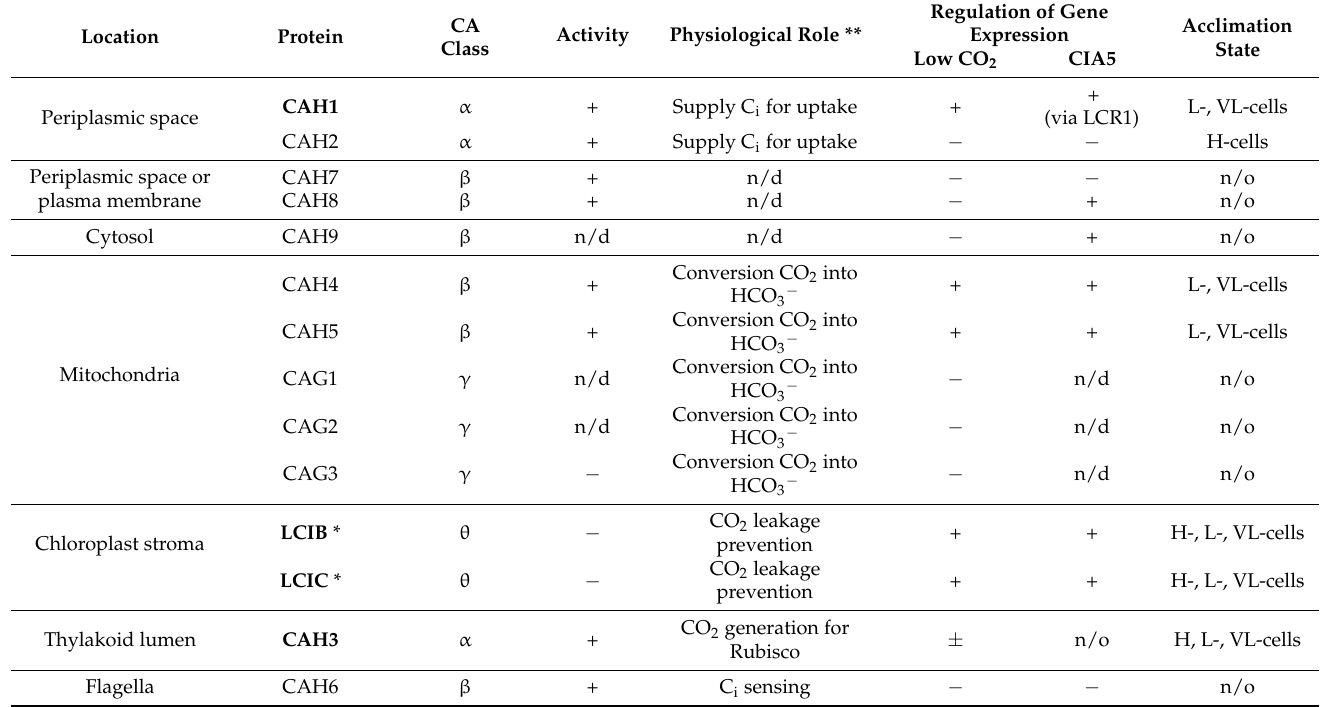
Table 2. Carbonic anhydrases and C i conversion system with putative CA activity in C. reinhardtii